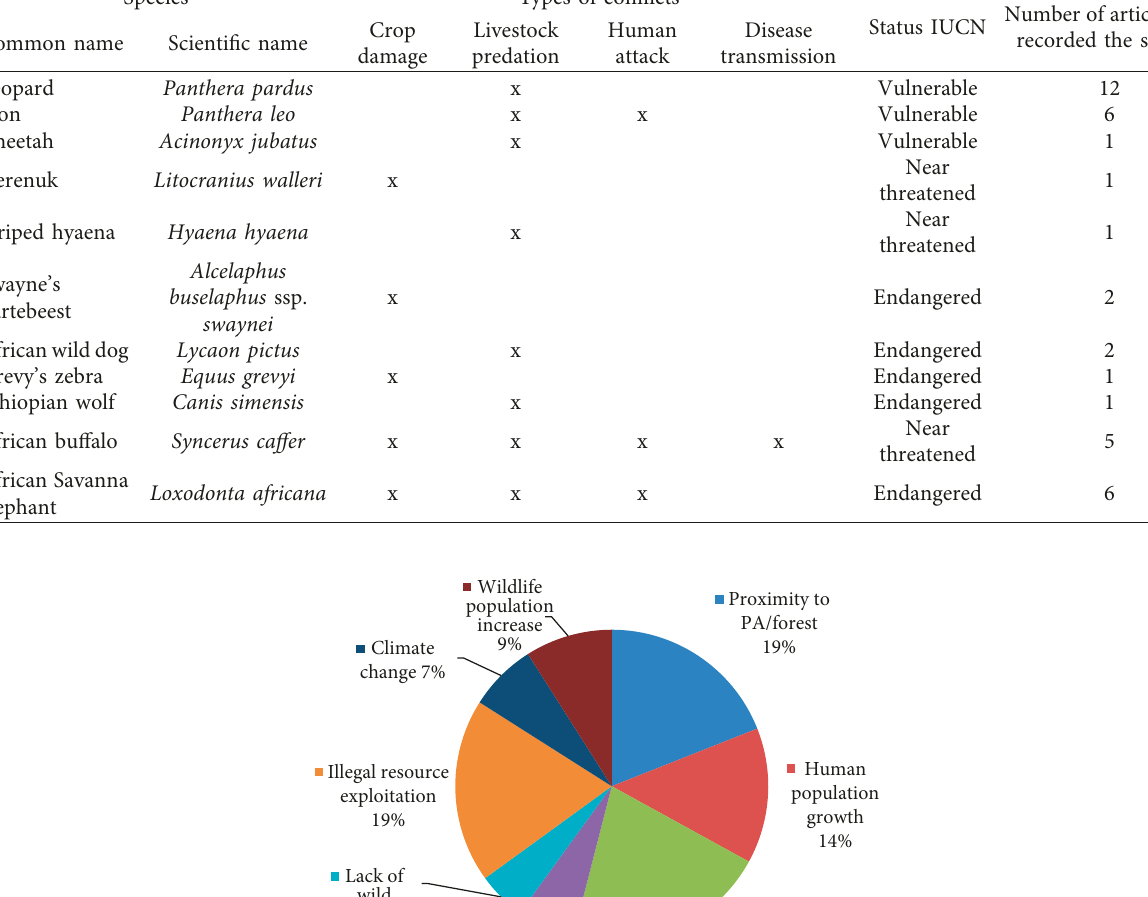
Table 1: Wild species listed in IUCN.